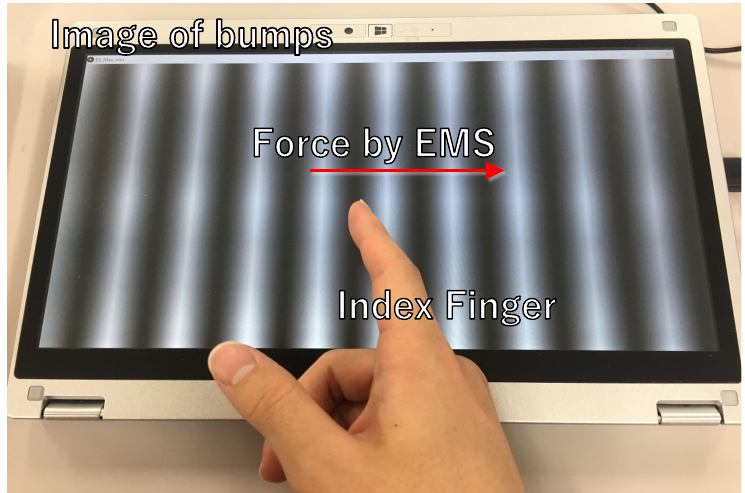
Figure 7. Haptic AR presentation